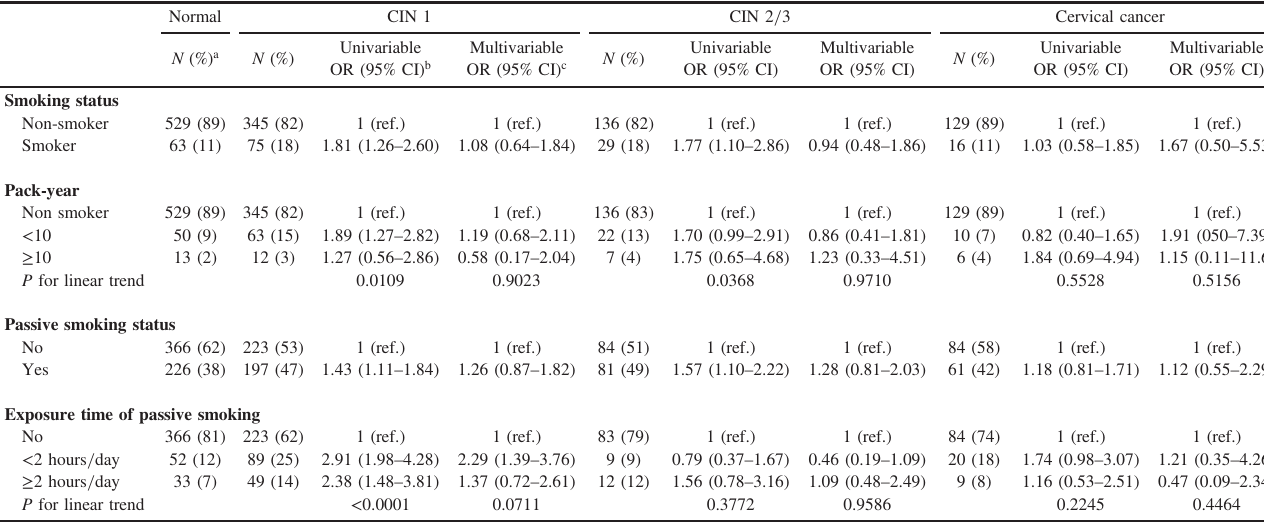
Table 2. Association of smoking and passive smoking with the risk of CINs and cervical cancer Normal